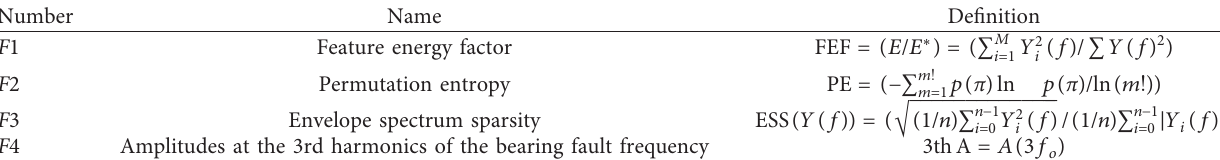
Table 2: Evaluation indicator.